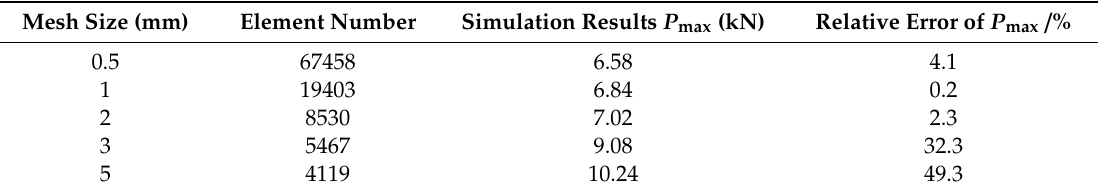
Table 2. Mesh size sensitivity analysis of concrete meso numerical model.